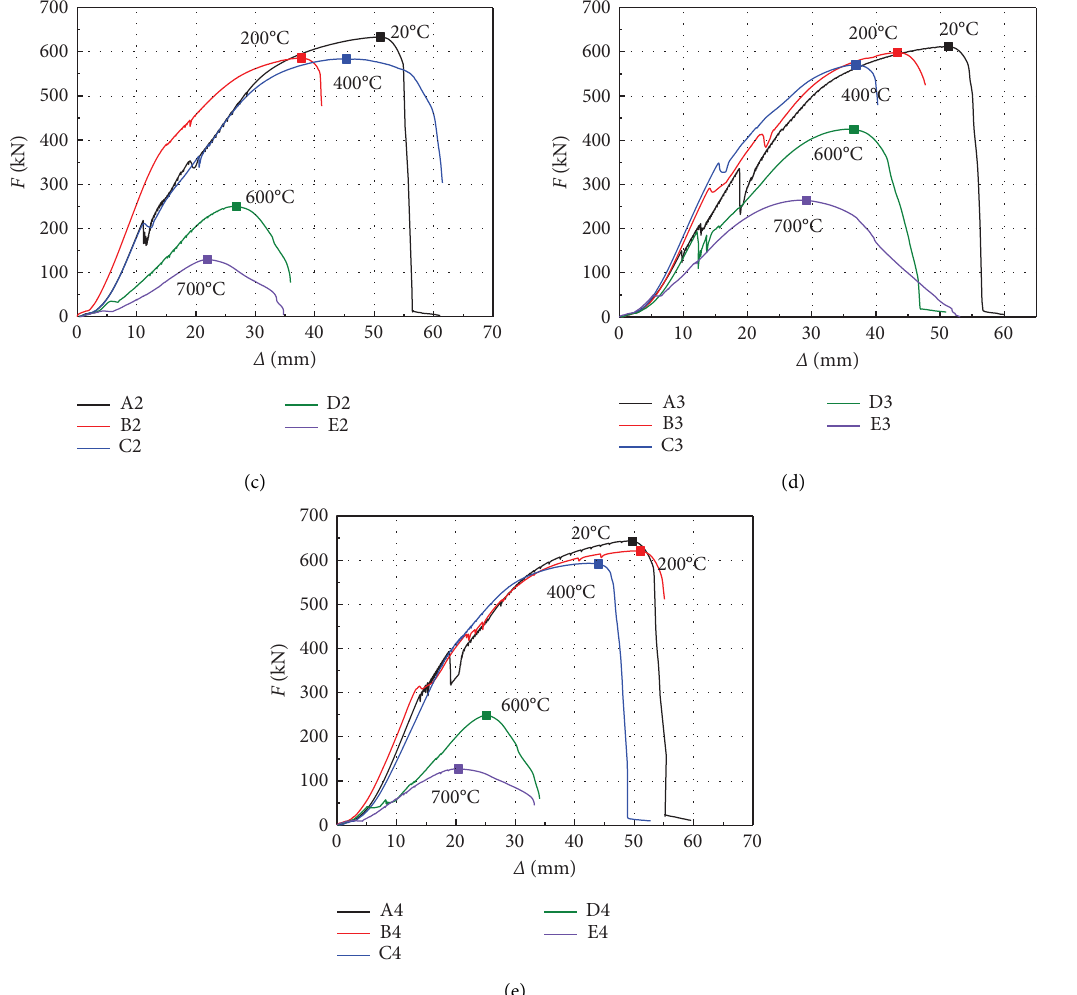
Figure 5: Te relationship between loading force and displacement of specimens. (a) B1. (b) Impeller blasting and fre-resistant bolts. (c) Impeller blasting and ordinary bolts. (d) Sprayed hard quartz sand and fre-resistant bolts. (e) Sprayed hard quartz sand and ordinary bolts.